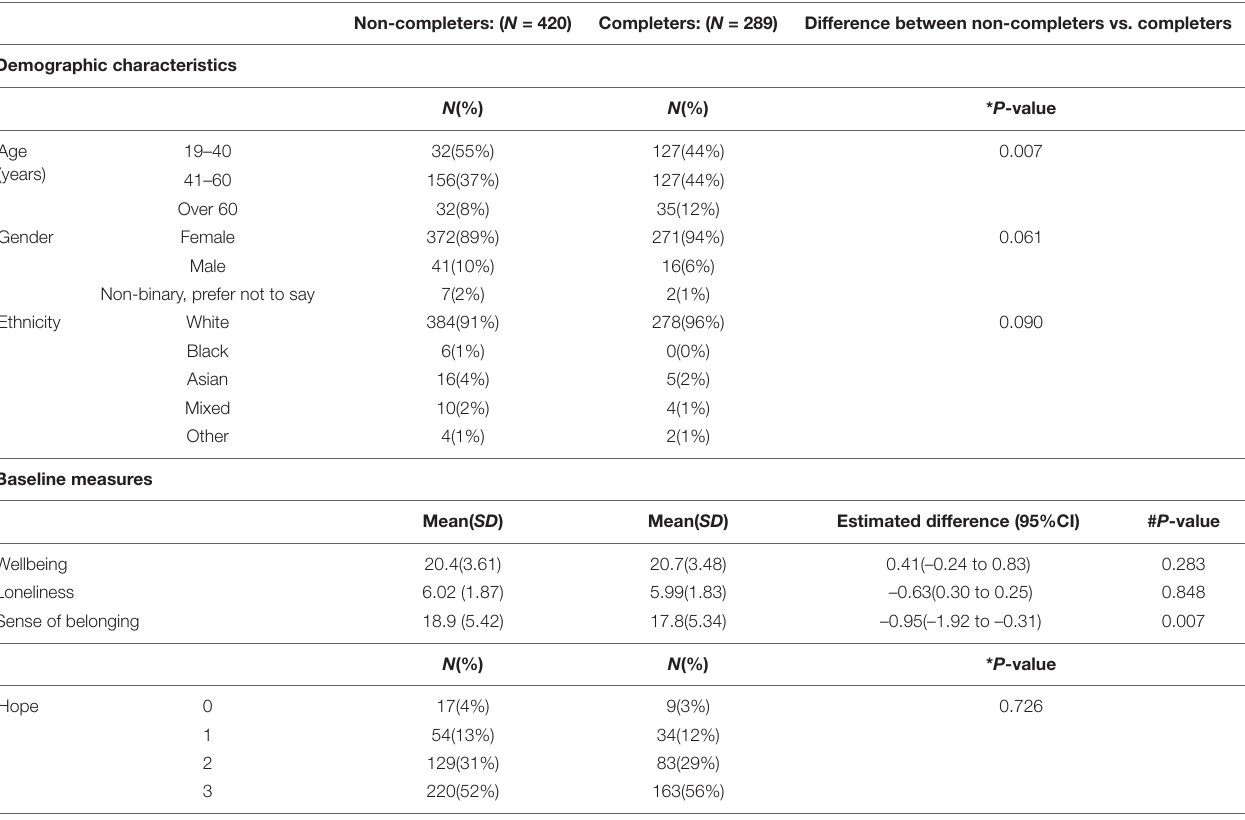
TABLE 1 | Demographic characteristics and baseline measures of participants. Non-completers: ( N = 420) Completers: ( N =